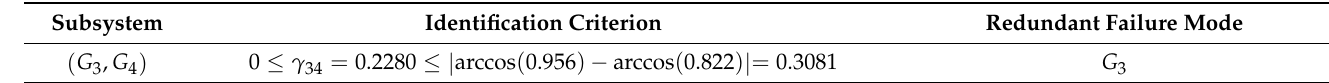
Table 3. Redundant failure mode and identification criterion for numerical example